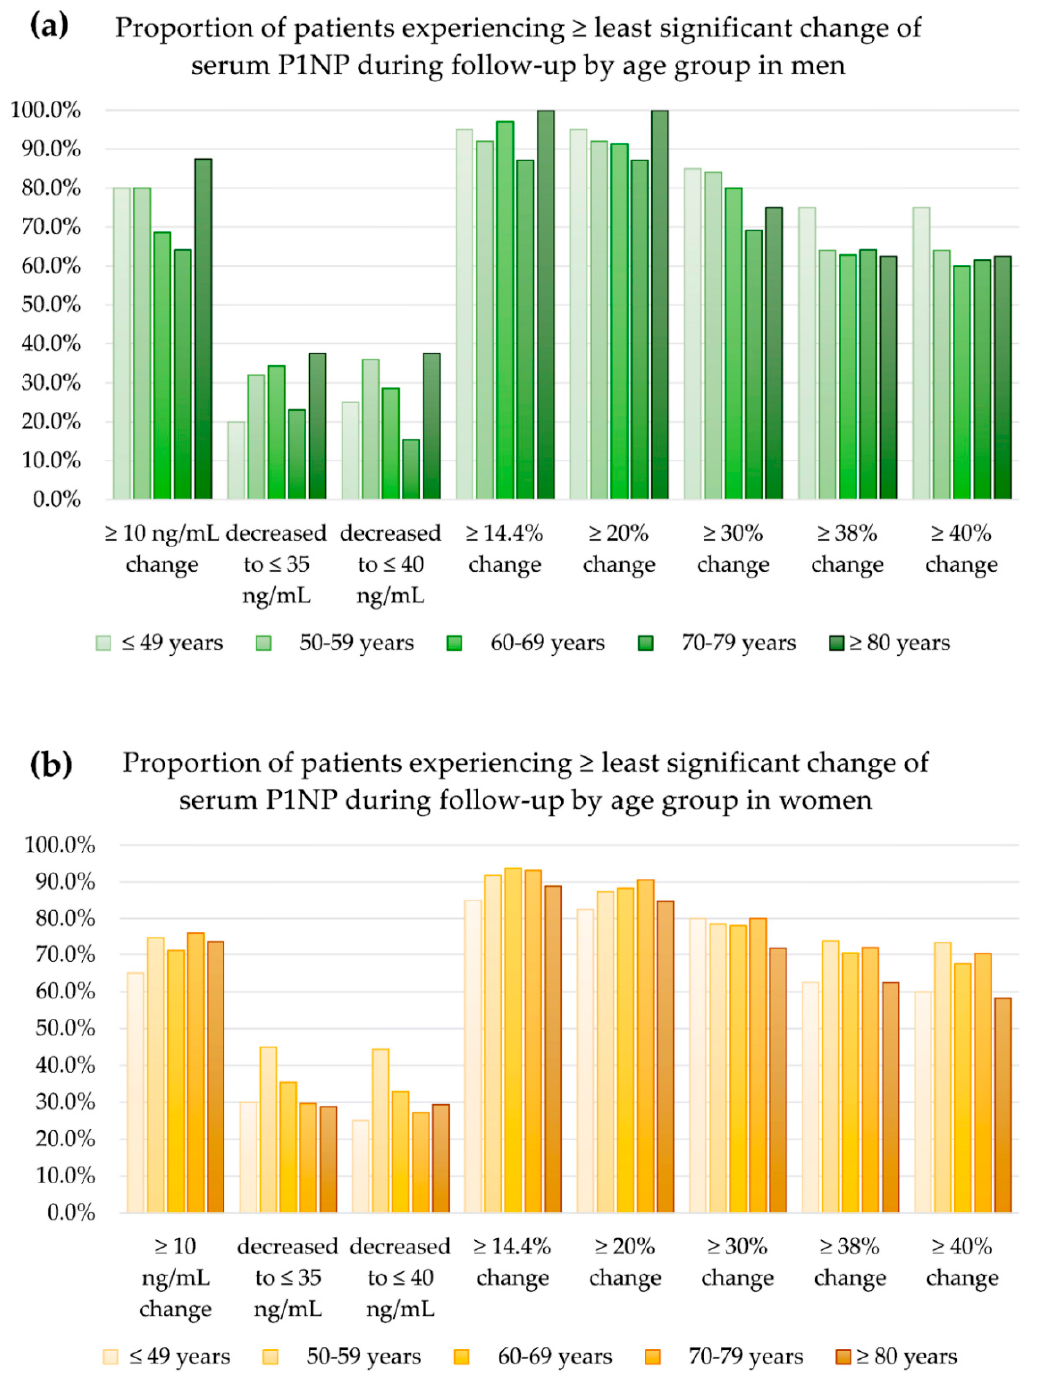
Figure 3. The proportion of patients experiencing changes in serum P1NP exceeding the least significant changes during follow-up: ( a ) in men and ( b ) in women.